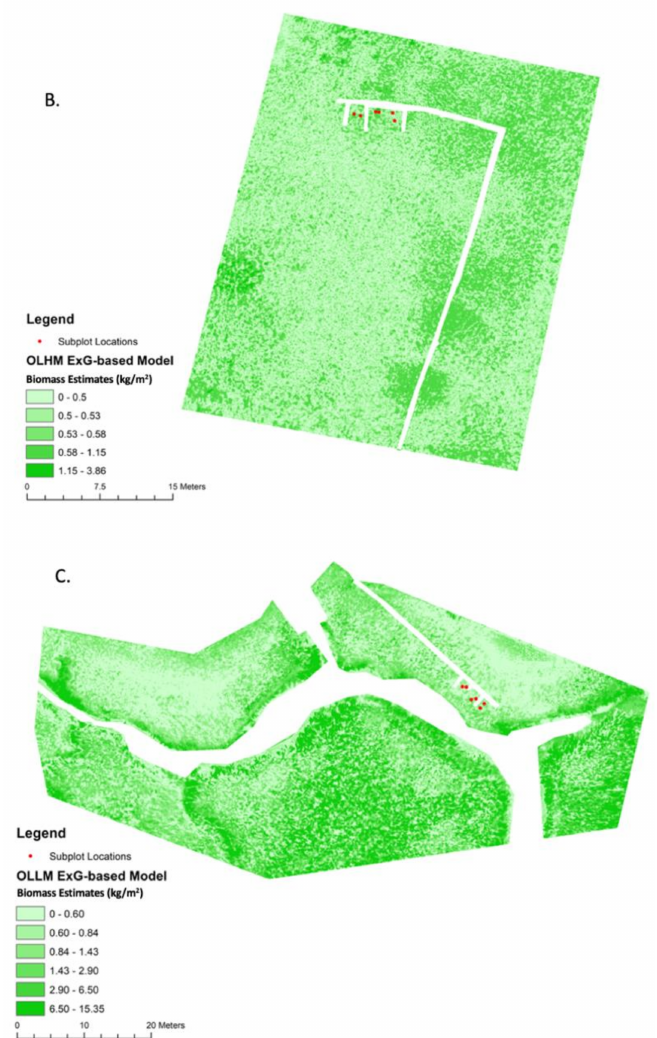
Figure 9. Biomass maps and sample point locations for GI ( A ), OLHM ( B ), and OLLM ( C ) using the ExG-based model. The two samples with the highest biomass (as shown in Figure 8) are circled in red in ( A